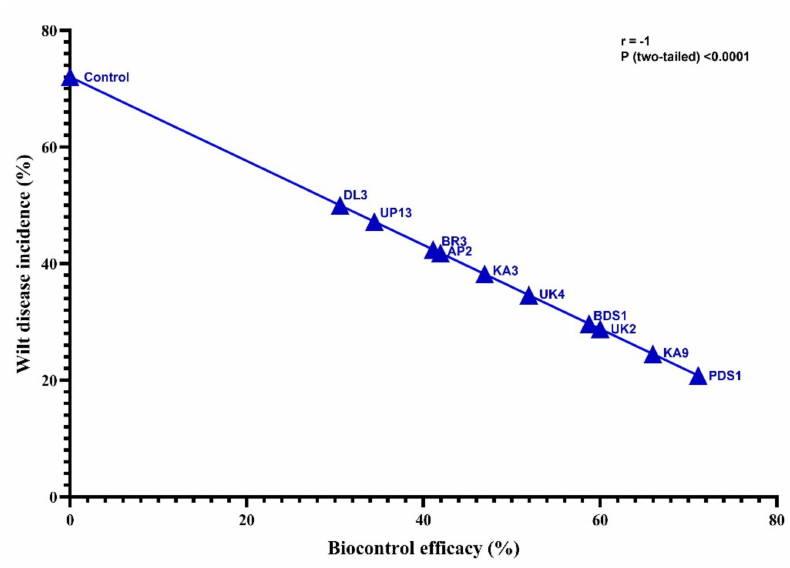
Figure 6. Correlation between wilt disease incidence and biocontrol efficacy of rhizobacterial strains on chilli